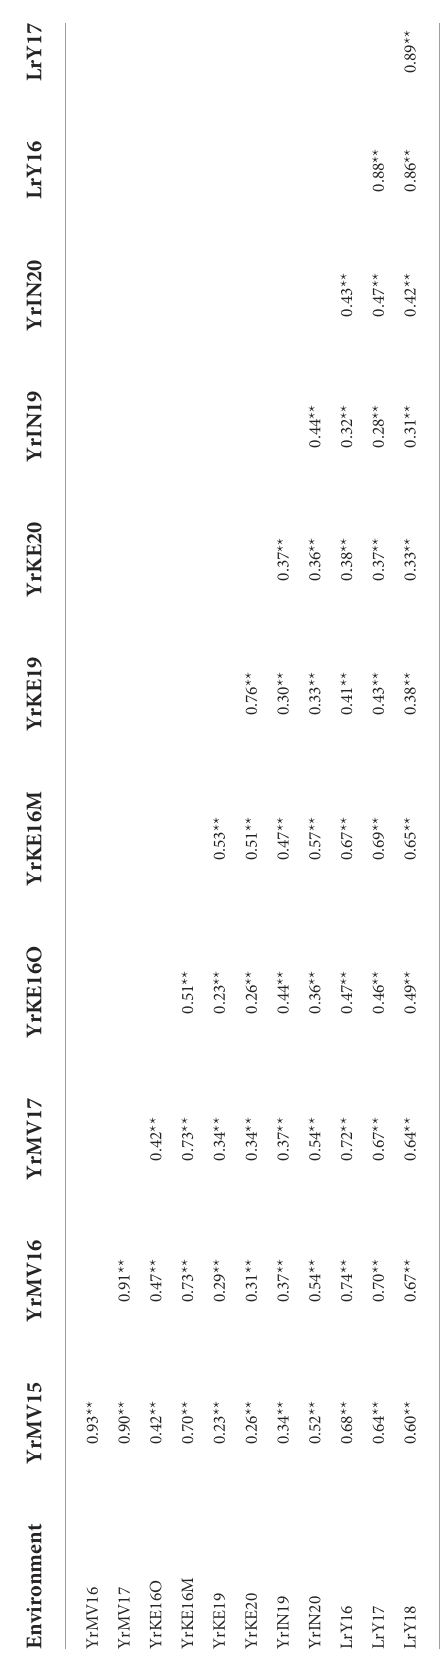
(Table 2, Figure 3C). We developed an InDel marker named InD_hzau_MuYLr-2AS that was genotyped on the F 5 RIL population (Supplementary Table 2); the single marker analysis showed that it was significantly correlated with both YR and LR phenotypes and co-located with YrMu (Supplementary Table